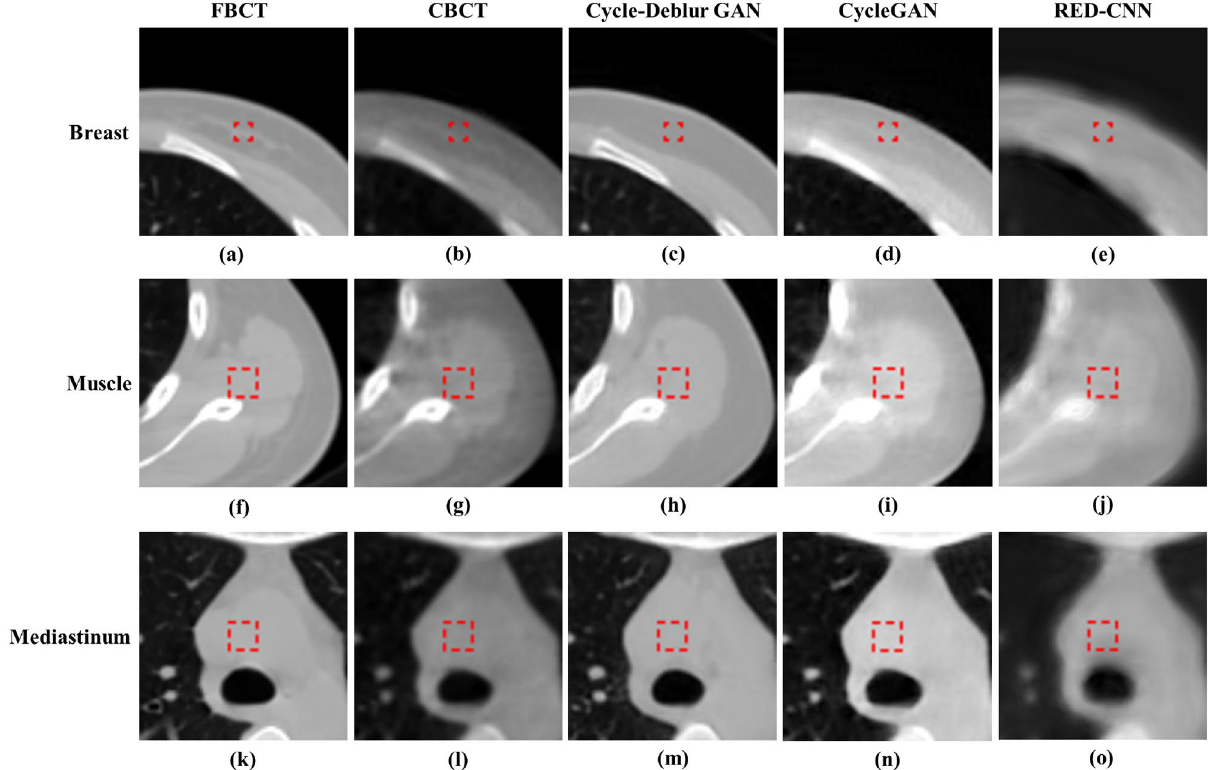
Figure 7. The soft tissue ROIs of the breast, muscle and mediastinum for quantitative evaluation are shown in ( a,f , k ): FBCT, ( b , g , l ): CBCT, ( c , h , m ): Cycle-Deblur GAN, ( d , i , n ): CycleGAN and ( e , j , o ): RED-CNN were performed by XVI software and PMOD software. (W = 1450, L = − 225 for all CT